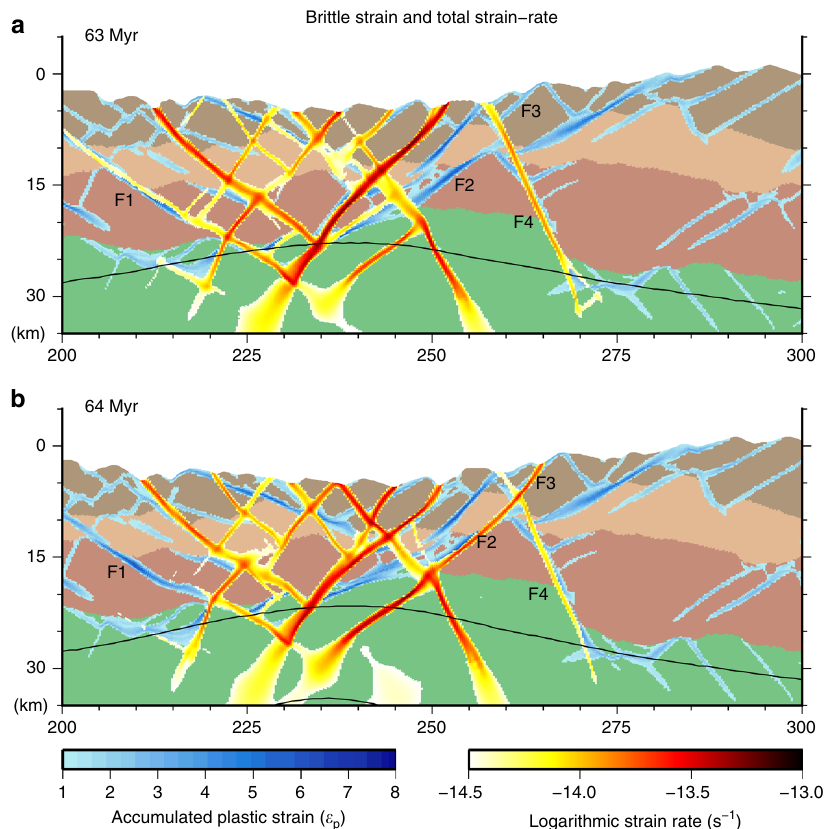
Fig. 4 Structural interpretation of fault evolution. Panels show the accumulated plastic strain, total strain-rate and temperature contours plotted on top of the compositional fi eld at a 63 and b 64 Myr. The structural interpretation follows four fault segments (F1 – F4) that illustrate examples of fault deactivation, reactivation, linkage and incision (see text for more